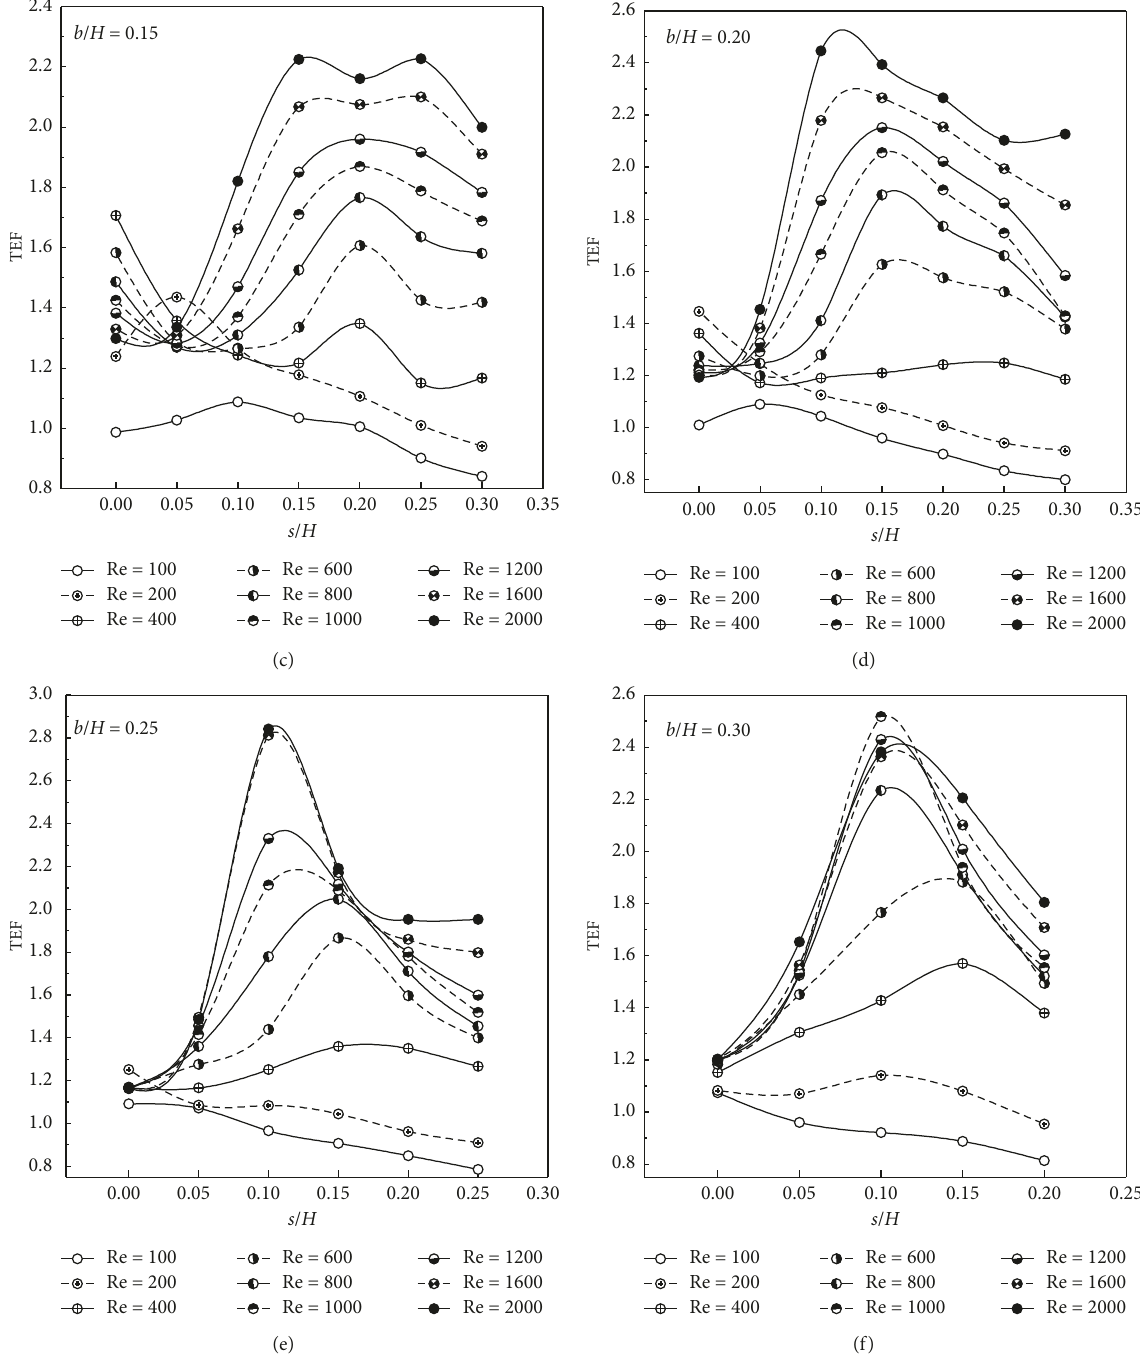
Figure 21: TEF versus s / H for the heat exchanger square duct installed with the 45 ° ISR at (a) b / H H 0.20, (e) b / H 0.25, and (f) b / H (cid:31) (cid:31)